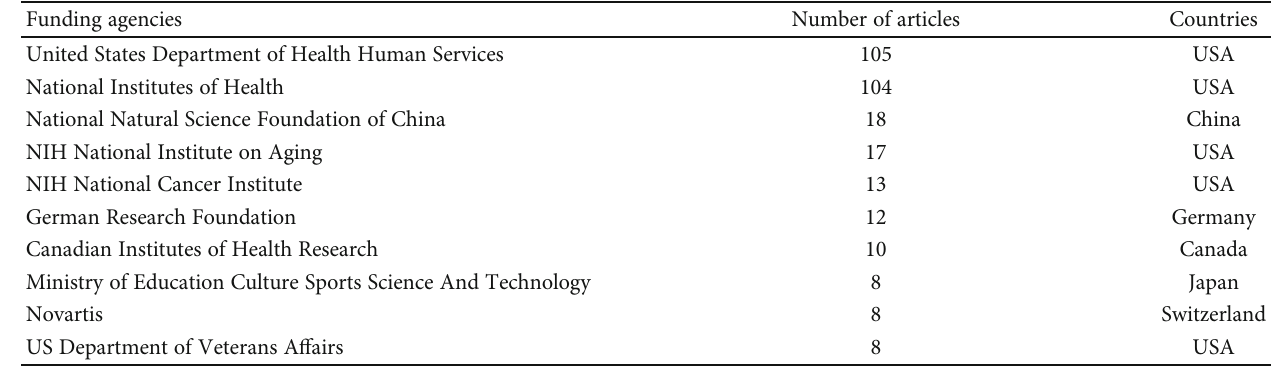
Table 3: Top 10 S1P and its application in age-related research funders.